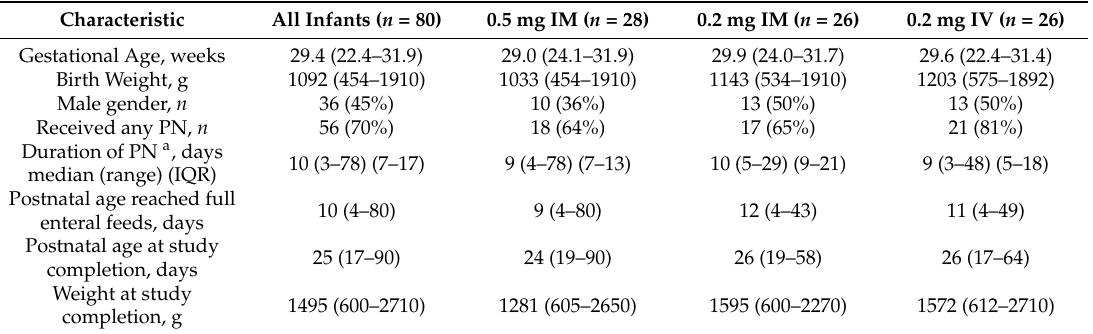
Table 2. Baseline characteristics of the n = 80 infants who completed the study and subgroups according to initial phylloquinone prophylaxis